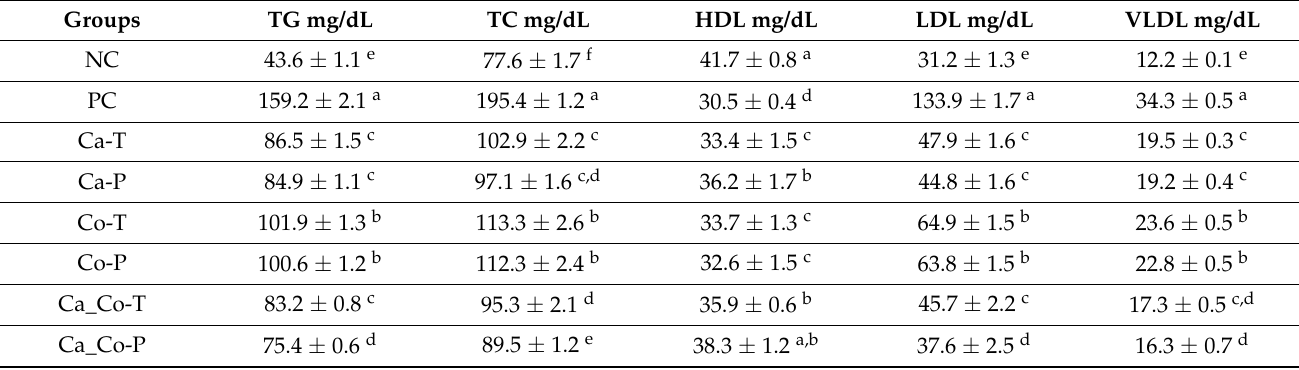
Table 4. Effect of different fermented milks on blood lipid profile in hypercholesterolemic